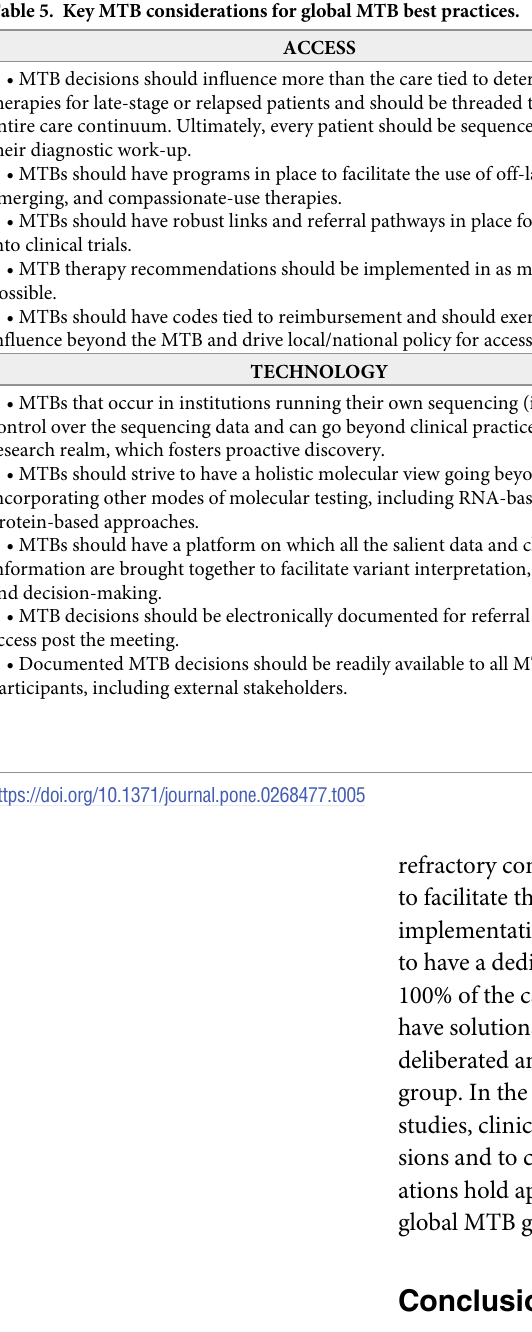
Table 5. Key MTB considerations for global MTB best